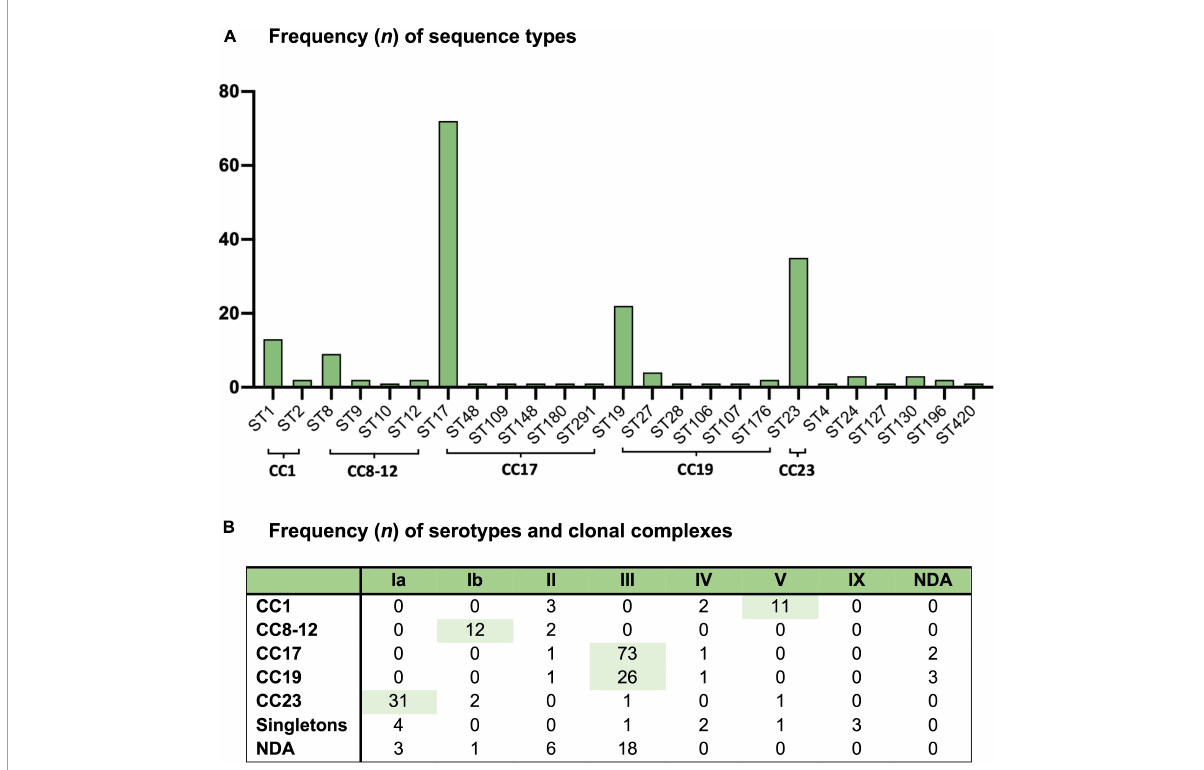
FIGURE1 Group B Streptococcus isolates from 212 Danish infants within 3 months of life from 1999 to 2009 and (A) the frequency of sequence types (ST) and (B) the frequency of serotypes (Ia-IX) and clonal complexes (CC). NDA, no data